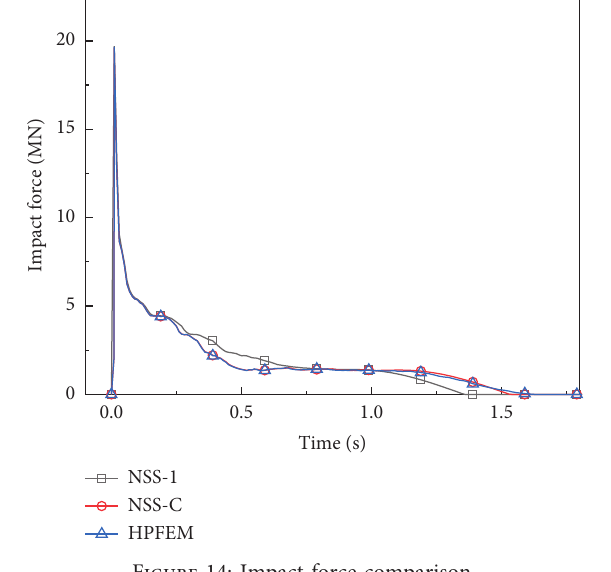
Figure 14: Impact force comparison.